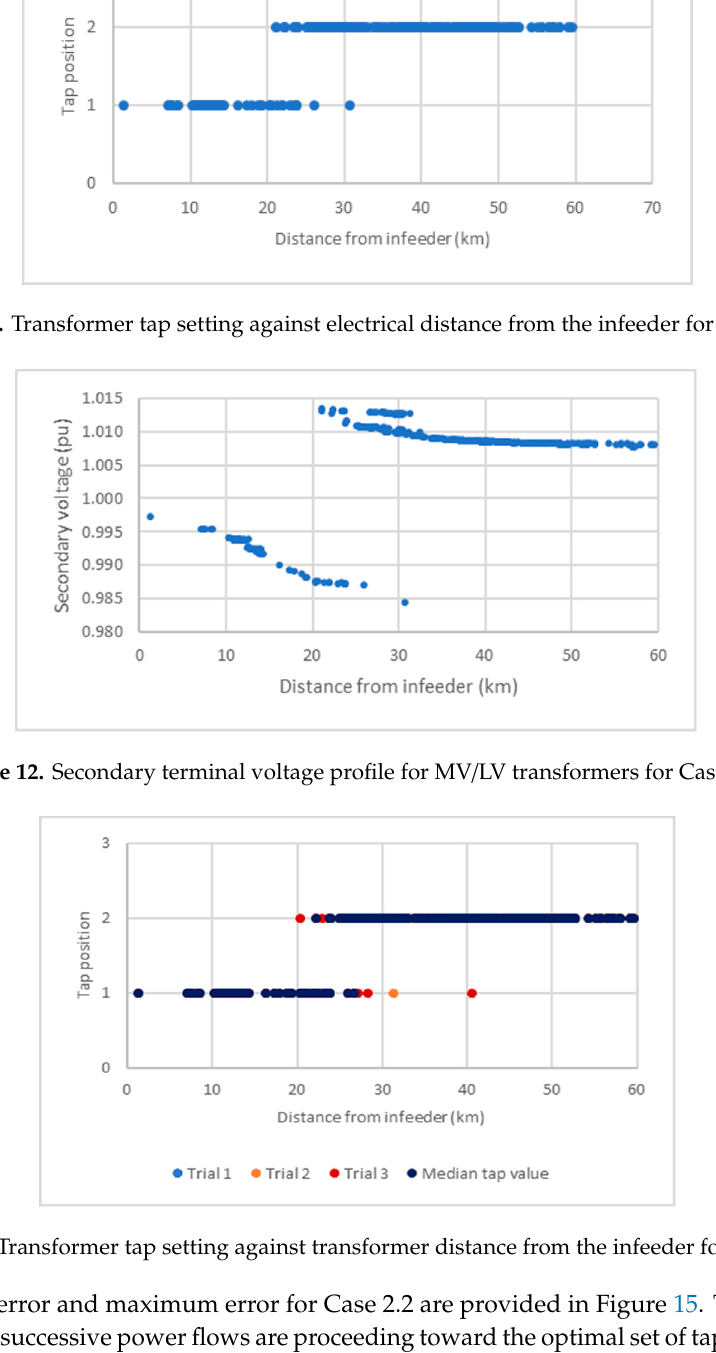
Figure 14. Secondary terminal voltage profile for MV/LV transformers for Case 2.2. The result had a better fitness than Case 2.1. The average error and maximum error for Case 2.2 are provided in Figure 15. The average error demonstrates that successive power flows are proceeding toward the optimal set of taps. The maximum error provides evidence to suggest why Case 2.1 was unable to find a set of taps with a fitness function less than or equal to Case 2.2. The optimal solution is close to several local minima in the problem space. Since Case 2.2 completes an ES multiple times, the median tap positions are more robust against becoming trapped in local minima. Ideally, Case 2.1 would be repeated to account for the random input tap settings, however, the excessive run time makes this approach impractical. ( a ) ( b ) Figure 15. Metrics measured for Case 2.2. ( a ) Average error Δ(cid:3365) of the secondary voltages between the results of consecutive power flows. ( b ) Maximum absolute error Δ (cid:3040)(cid:3028)(cid:3051) of the secondary voltages between the results of consecutive power flows.